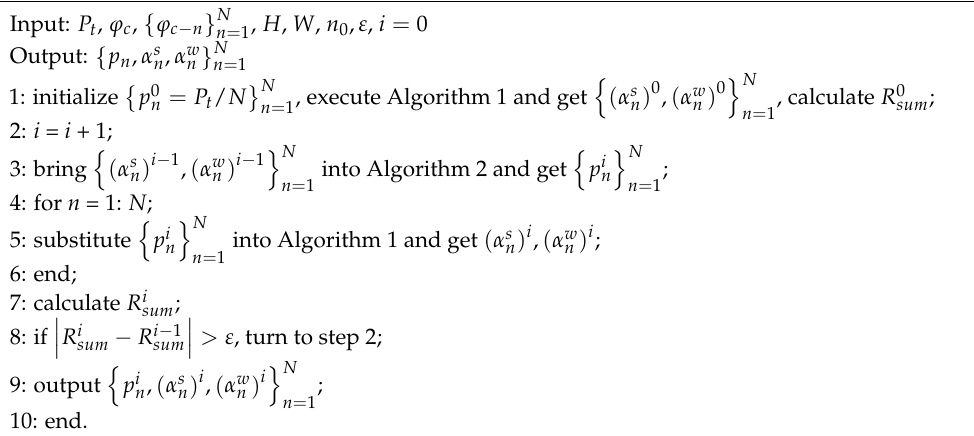
Algorithm 3: Joint power allocation inter and intra cluster under fairness